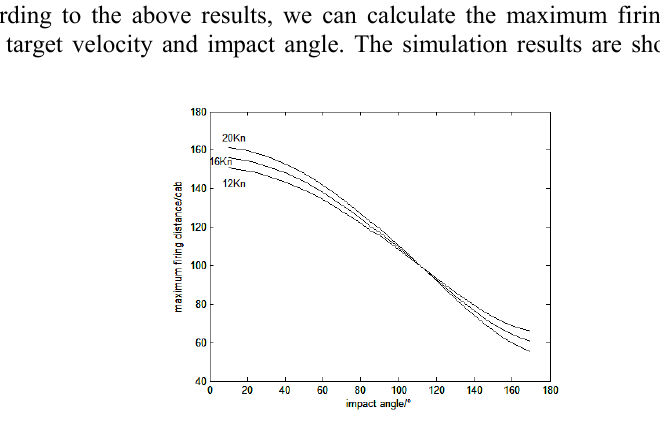
Fig. 4. The maximum firing distance of active acoustic homing torpedo.